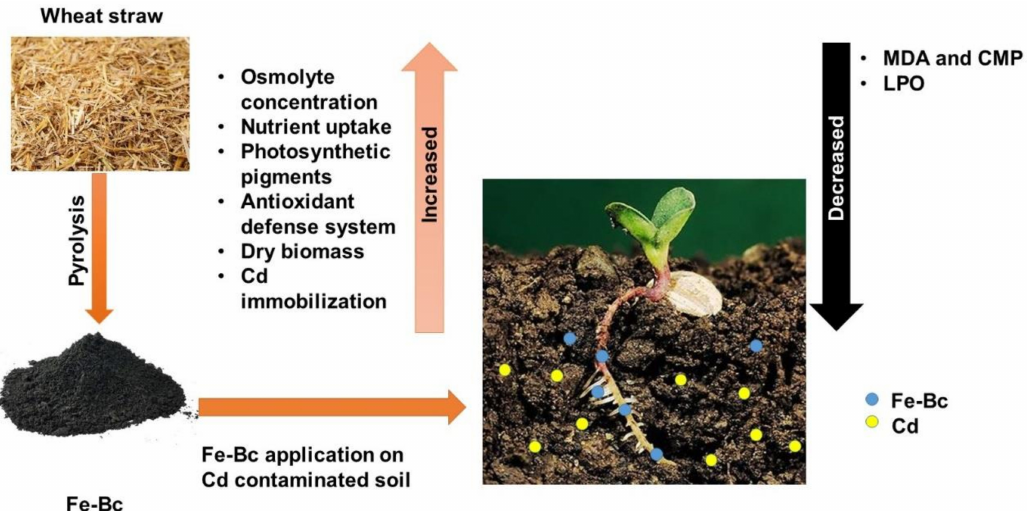
Figure 5. A graphical summary of the current study; biochar was made from wheat straw and doped with iron to improve BC productivity. Fe-BC improves Cd tolerance in radish by reducing the Cd translocation from root to shoot, by improving photosynthetic pigment accumulation and plant mineral nutrient and biomass accumulation. Fe-BC also improved Cd tolerance by regulating redox